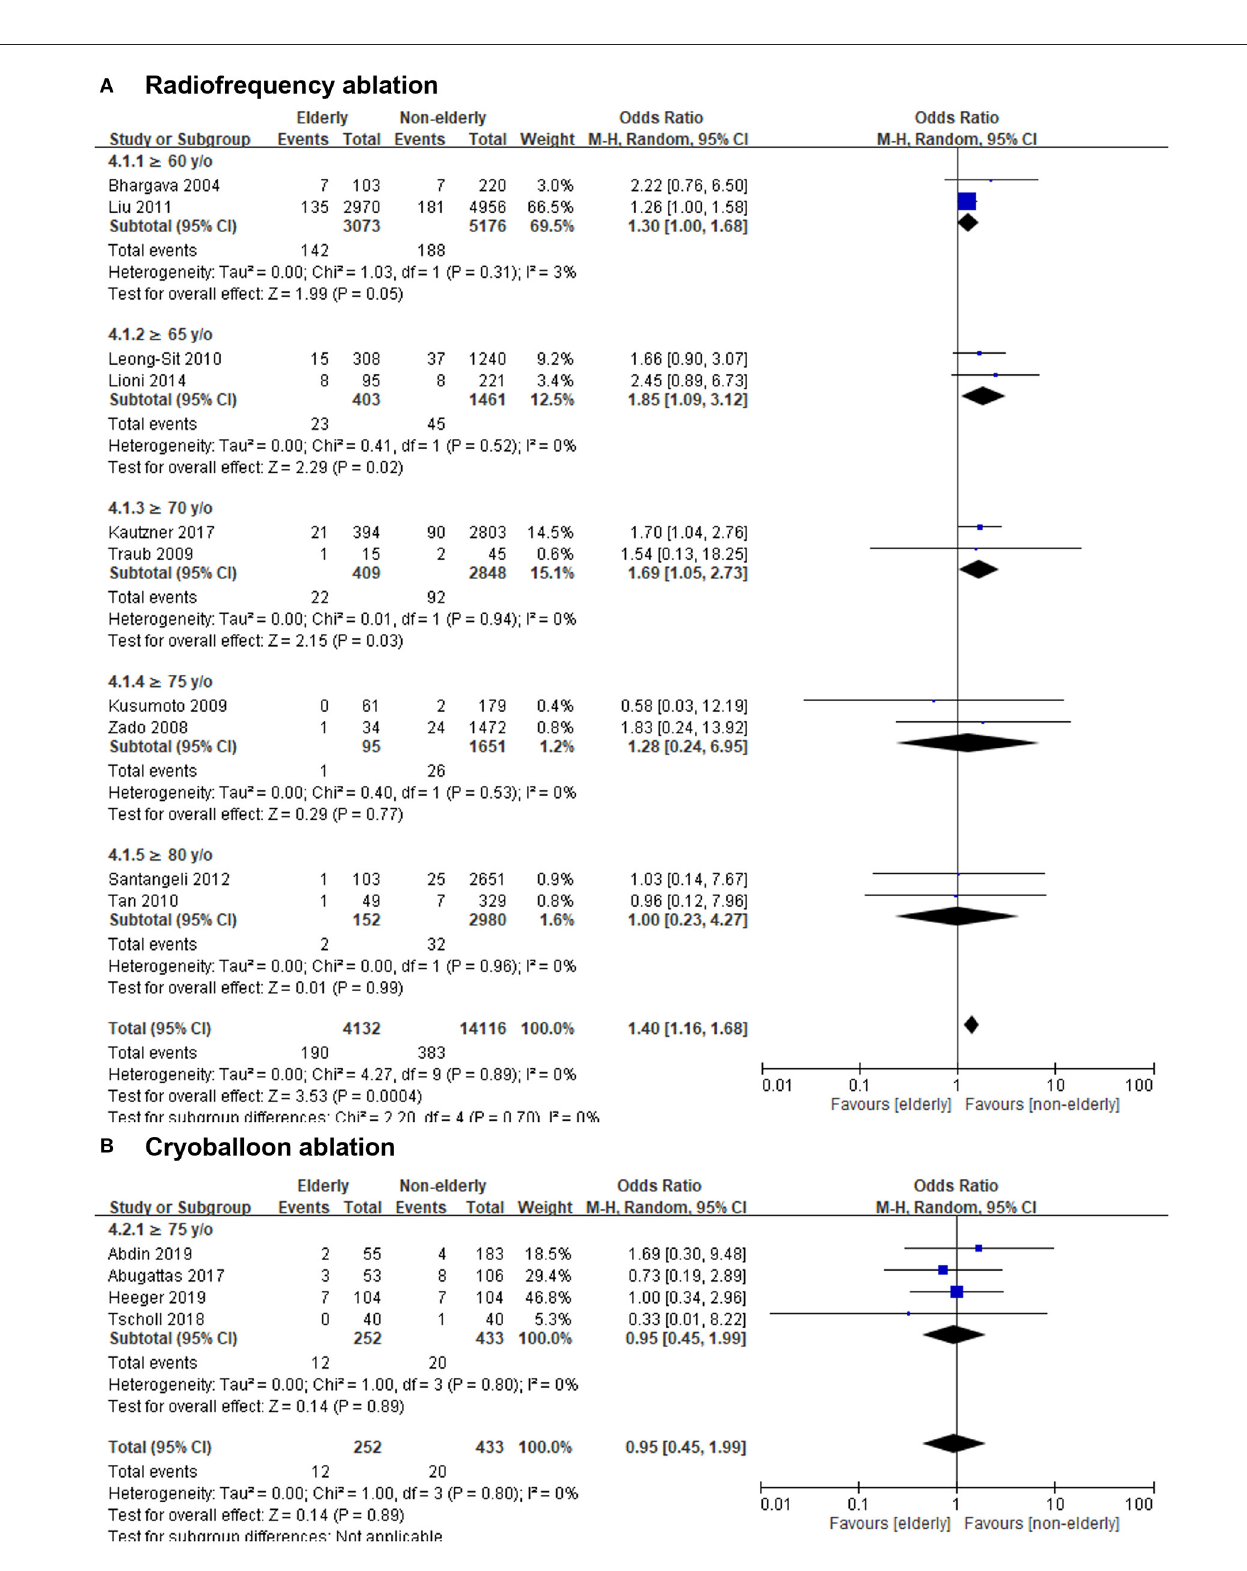
FIGURE 6 | Forest plots of the OR of complications of RF ablation (A) or cryoballoon ablation (B) between the elderly and non-elderly groups in the entire population from 14 studies with different age stratification.